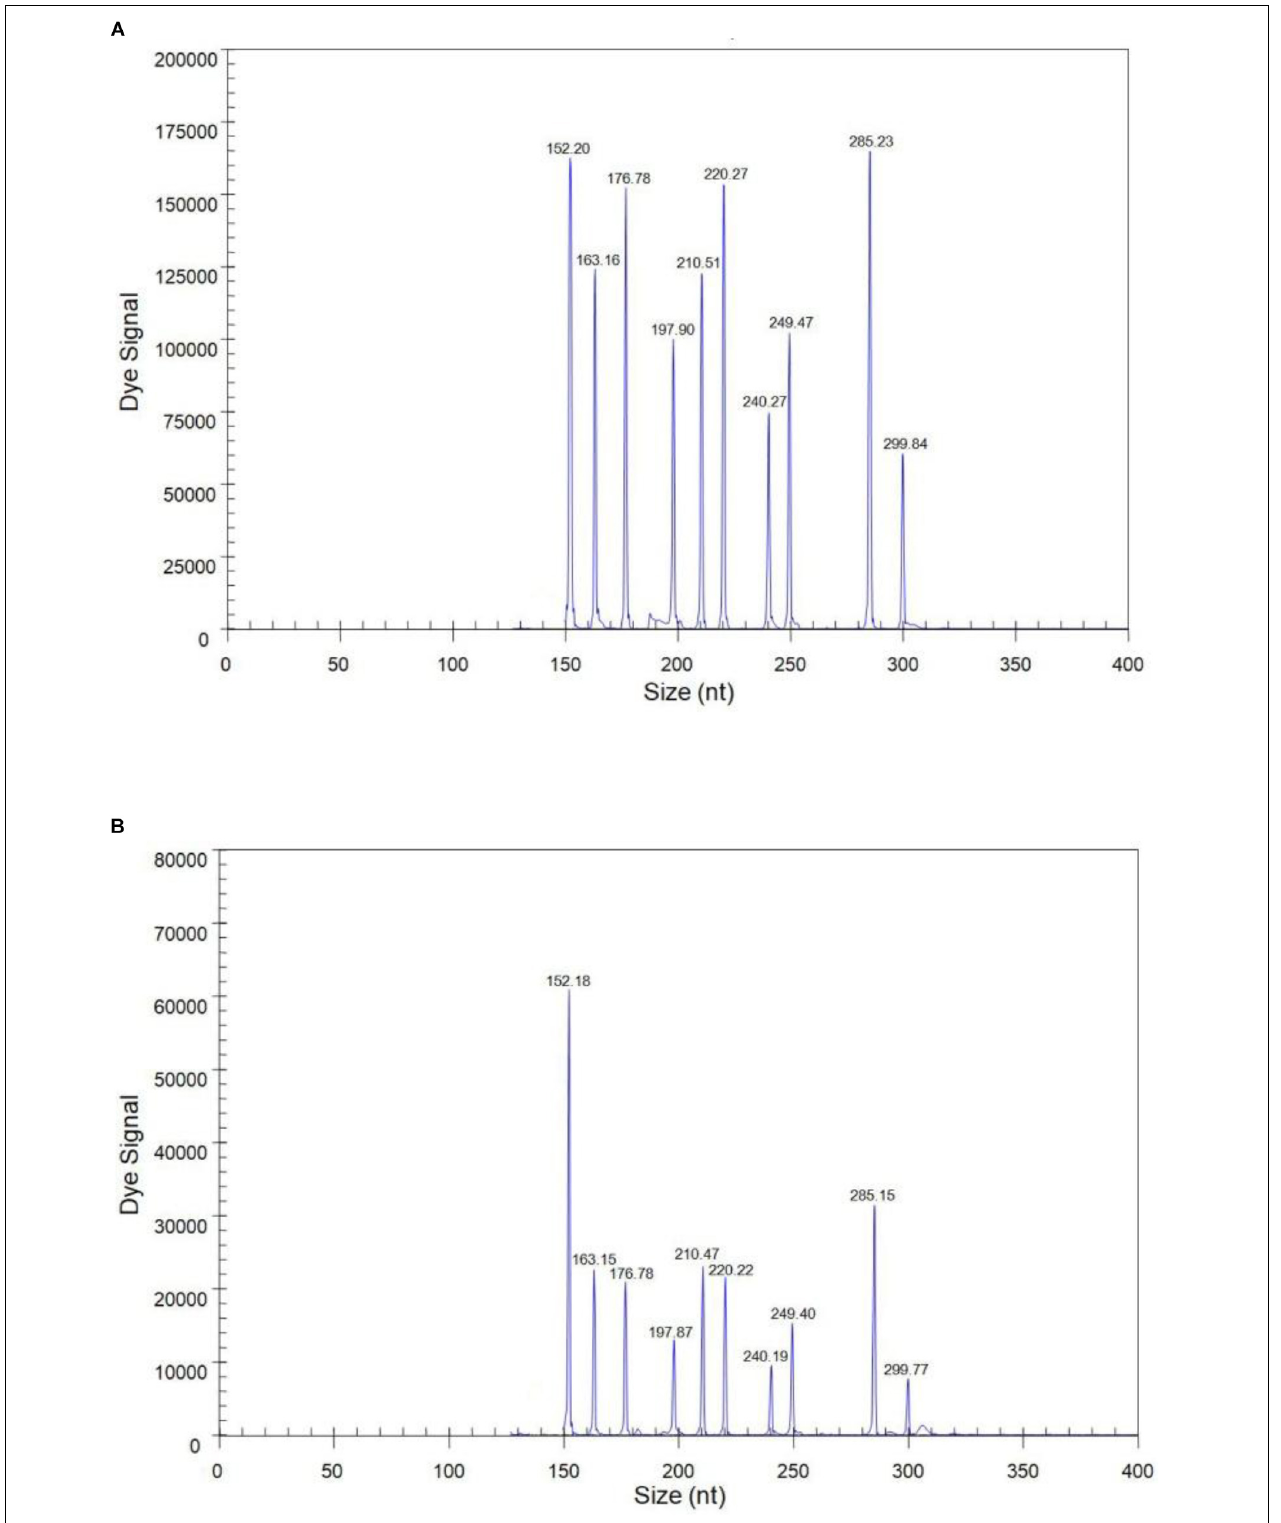
FIGURE 2 | The sensitivity of the GeXP assay for the simultaneous detection of nine NA subtypes of AIV. All 10 premixed viral targets were detected. (A) 10 3 copies per reaction mixture; (B) 100 copies per reaction mixture.